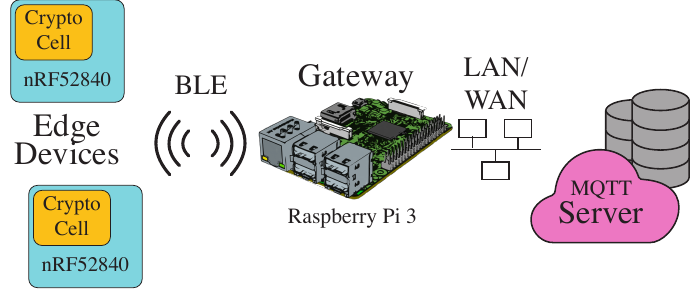
Figure 5. Network topology of the evaluated IoT system